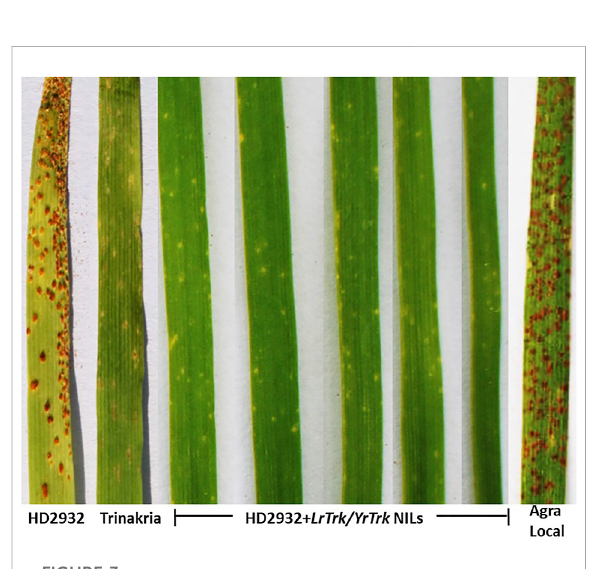
FIGURE 3 Representative fi gure showing infection type (IT) of HD2932 NILs carrying LrTrk/YrTrk with leaf rust pathotype